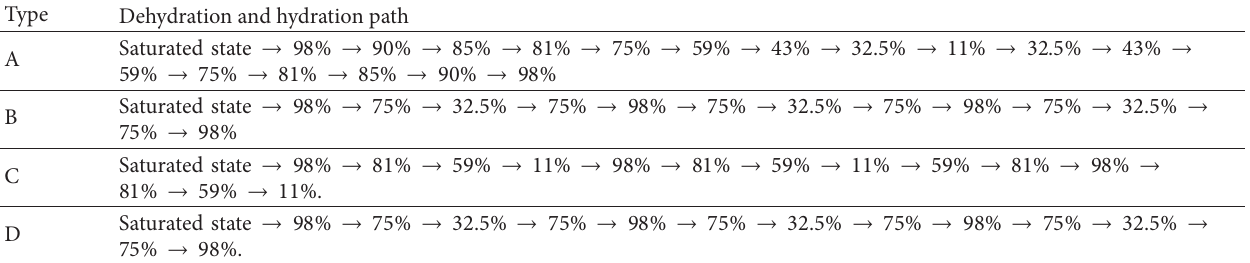
Table 1: Four different dehydration and hydration